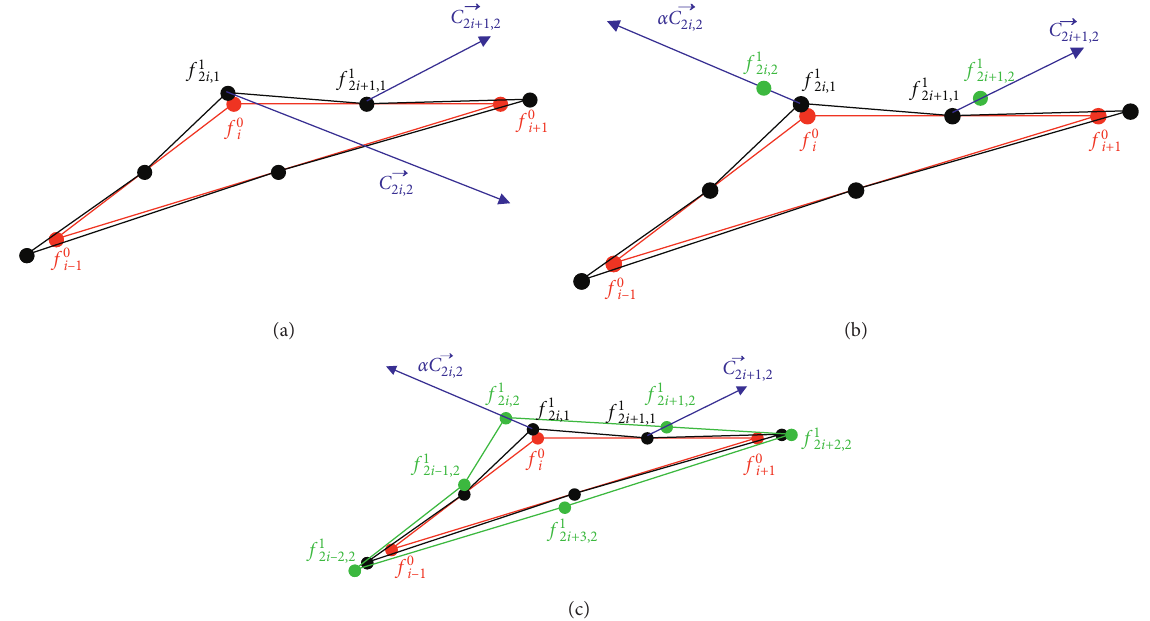
Figure 3: Geometrical interpretation of the proposed framework. Red bullets and red lines represent initial points and initial polygons, respectively. Black bullets and black lines represent the points and the polygons obtained by the subdivision scheme (17). Green bullets and green lines represent the points and the polygons obtained by the subdivision scheme